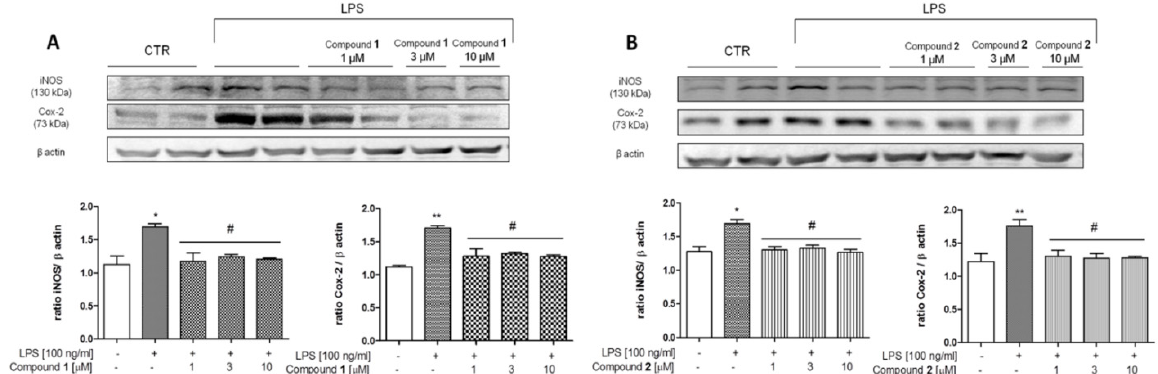
Figure 10. Effect of ( A ) 1 and ( B ) 2 on COX-2 expression in J774A.1 cells. Lysates were obtained from control cells and 24 h-treated cells with both compounds at increasing concentrations (1–3–10 µ M) after 24 h LPS (100 ng/mL) treatment. A representative immunoblot is shown. Densitometric analysis of protein bands was performed on three separate experiments. * p < 0.05 and ** p < 0.01 vs. control cells; # p < 0.05 vs. LPS-treated cells. “+ (presence), − (absence)” of LPS or of the compounds under study.